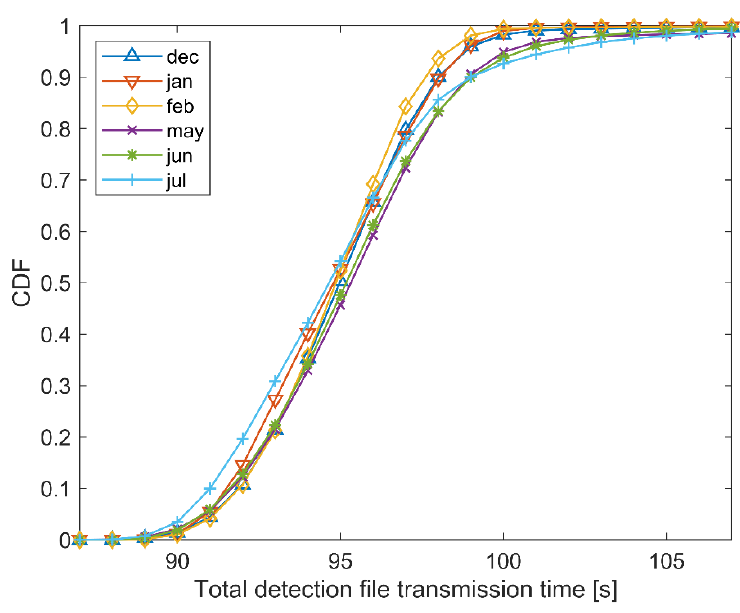
Figure 16. CDF for detection file size range 25 – 35 kB.